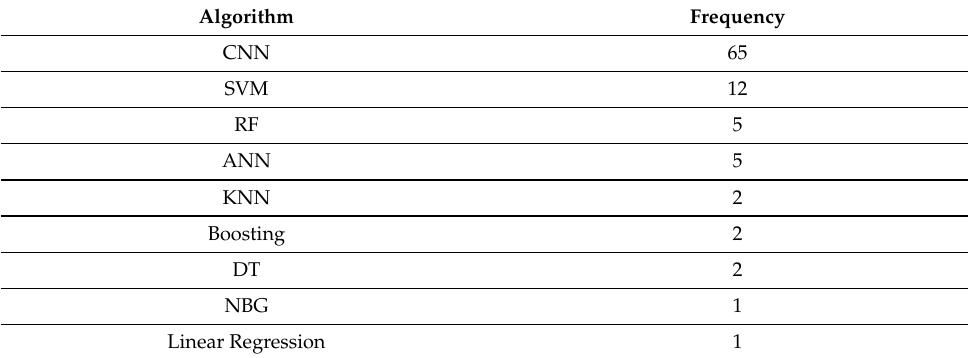
Table 4. Frequency Distribution of